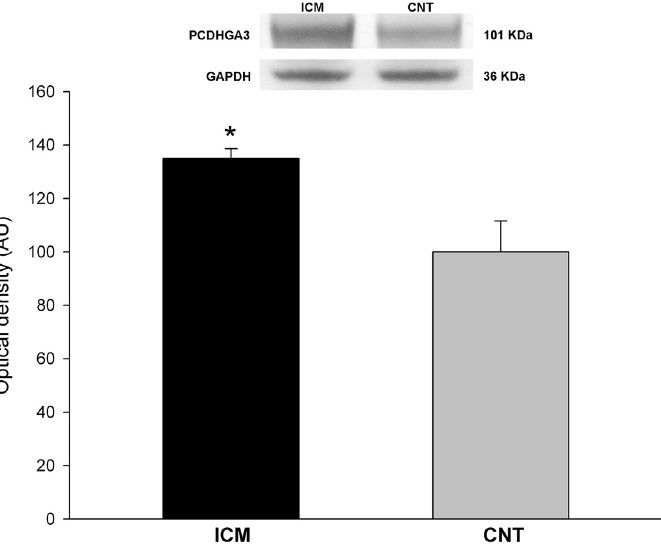
Fig 4. Increased protein levels of PCDHGA3 in ICM patients. The values of the CNT group, previously normalized to GAPDH, were set to 100. The data are expressed as mean ± SEM in optical density arbitrary units (AU). * P < 0.001, vs the CNT group. ICM, ischemic cardiomyopathy; CNT,